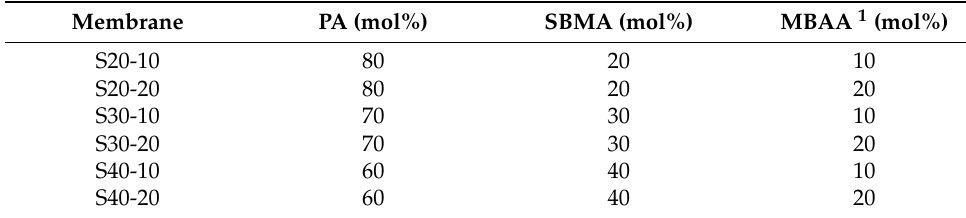
Table 1. Pre-polymerization mixture